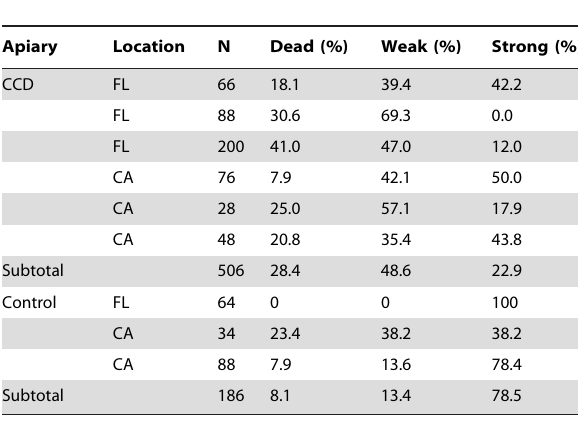
Table 4. Percentage of adequately strong, weak and dead colonies in apiaries containing colonies with symptoms of CCD and apparently healthy (control)